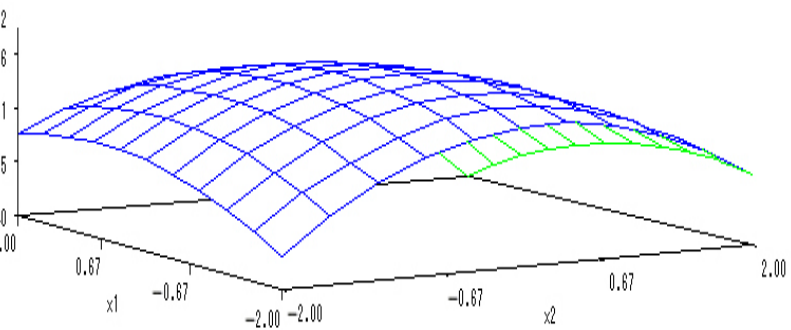
Figure 4. The 3-D map of mutual effect of N and P fertilizers on content of soluble protein content in melon.